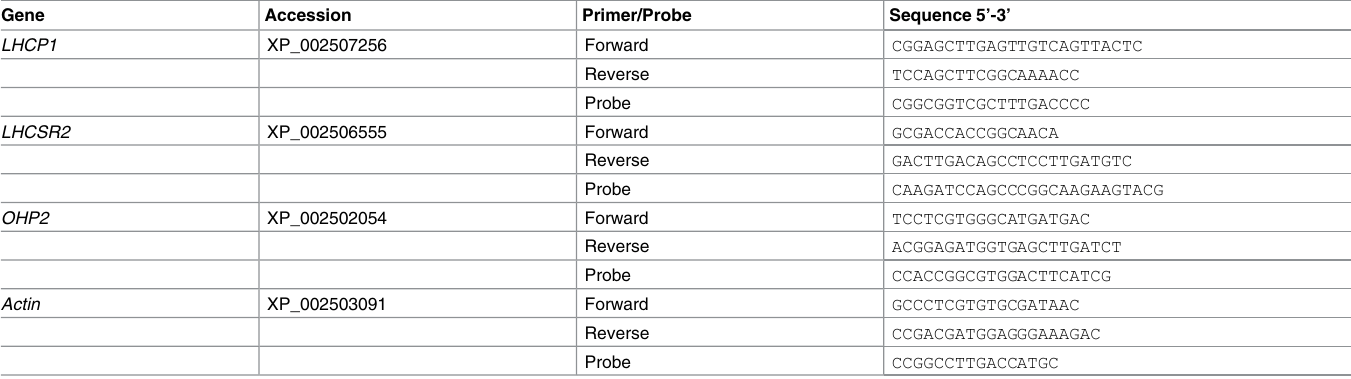
Table 1. Primer/probe set sequences designed and used here for three nucleus genes targeted to the chloroplast and the house-keeping gene Actin .